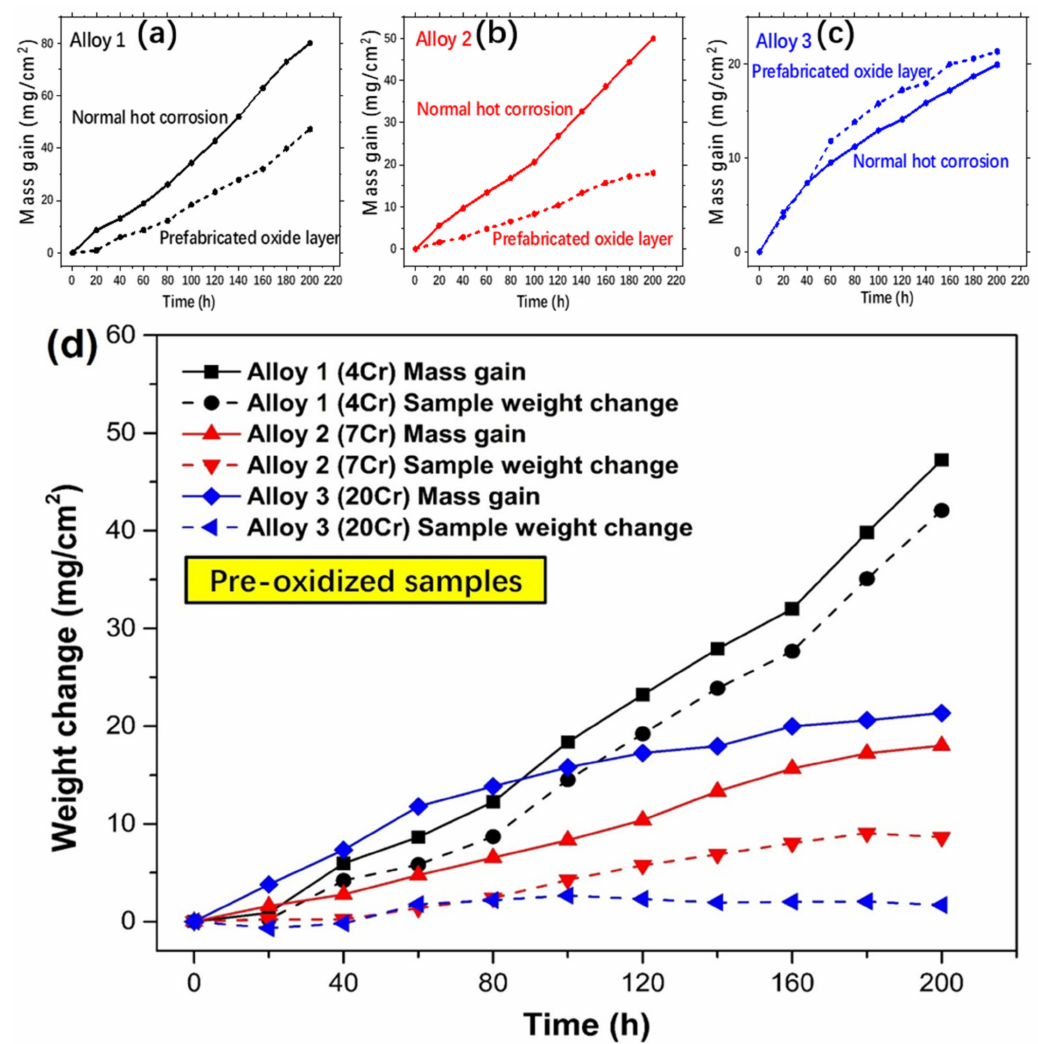
Figure 4. The hot-corroded kinetic curves of the prefabricated oxidation alloys compared to pure alloys in the atmosphere at 900 ◦ C in 200 h: ( a ) Alloy 1, ( b ) Alloy 2, ( c ) Alloy 3 and ( d ) the weight changes of the three alloys specimens after hot corrosion.